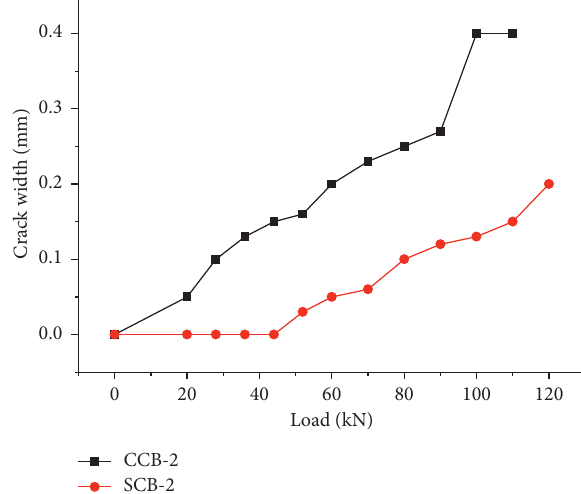
Figure 19: Development of crack width at the middle